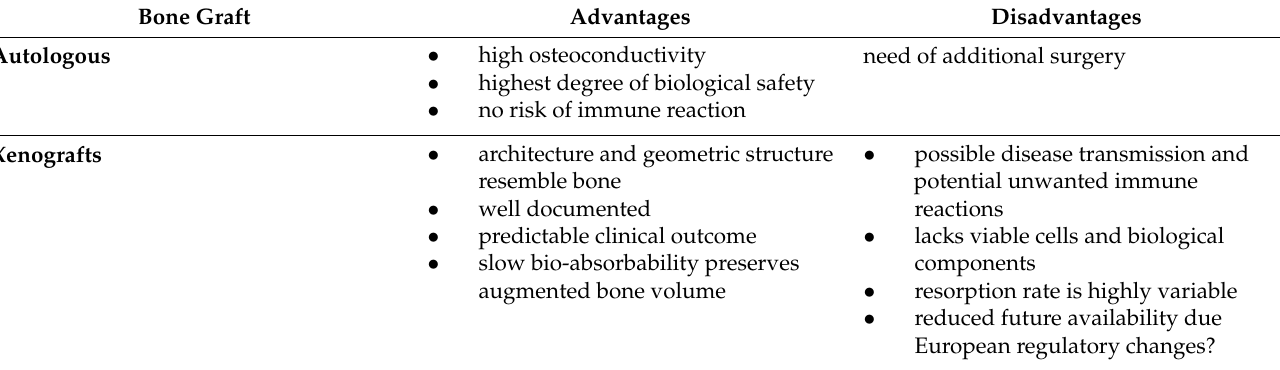
Table 1. Advantages and disadvantages of bone graft materials, modified with permission from [10]. Bone